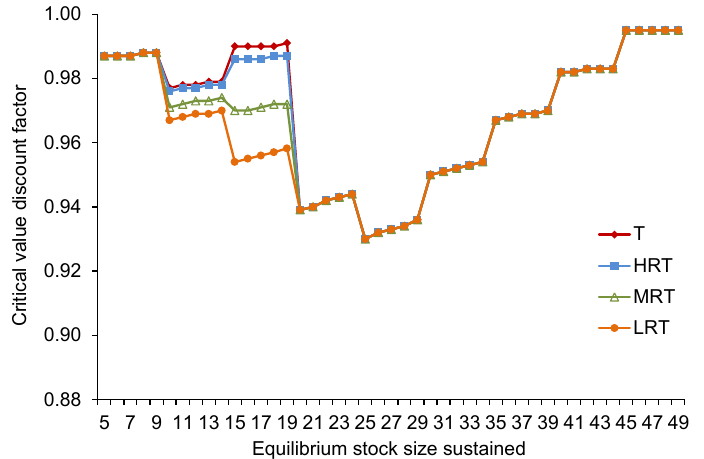
Fig. A6.1. Comparison of the critical values of the discount factor for the threshold (T), high-risk (HRT), medium-risk (MRT) and low-risk (LRT) treatment with four